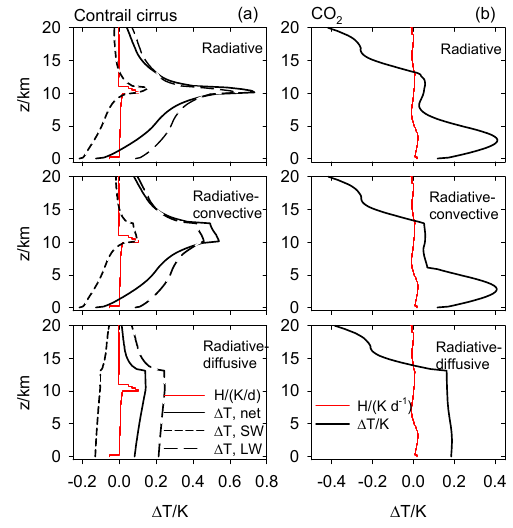
Figure 8. Temperature change (cid:49)T in K versus altitude z in km (black lines) for disturbances by CO 2 (right) and by SW, LW, and combined LW + SW contrail cirrus (left) in steady state for the ra- diative, radiative-convective, and radiative-diffusive cases. The red curves show the net (LW + SW) initial instantaneous heating ratings in Kday − 1